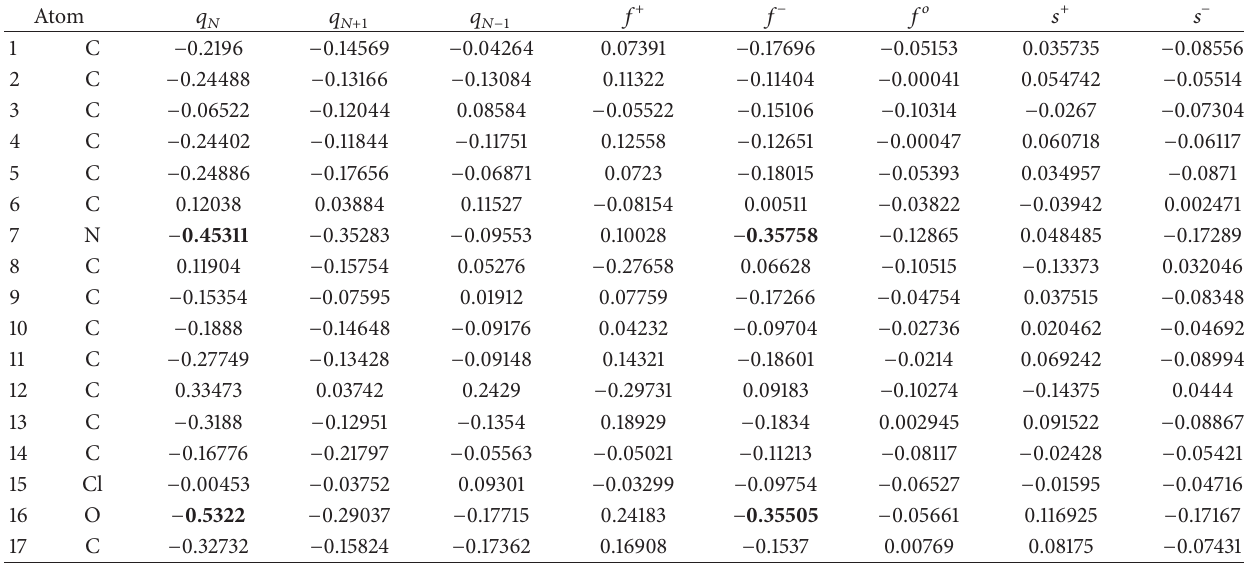
Table 3: Calculated natural charges, Fukui functions, and local softness indices for the schiff base (4-CNMBA).